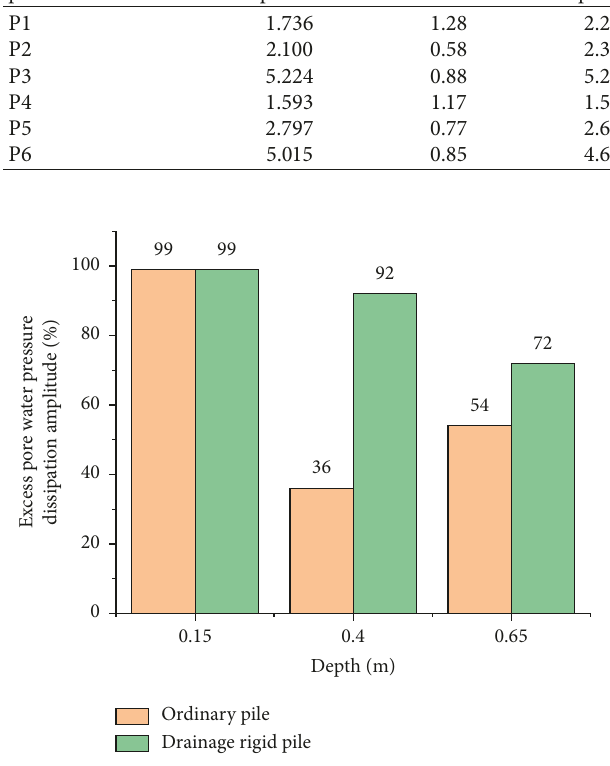
Table 3: Excess pore water pressure and PPR of each measurement point. Pore water pressure